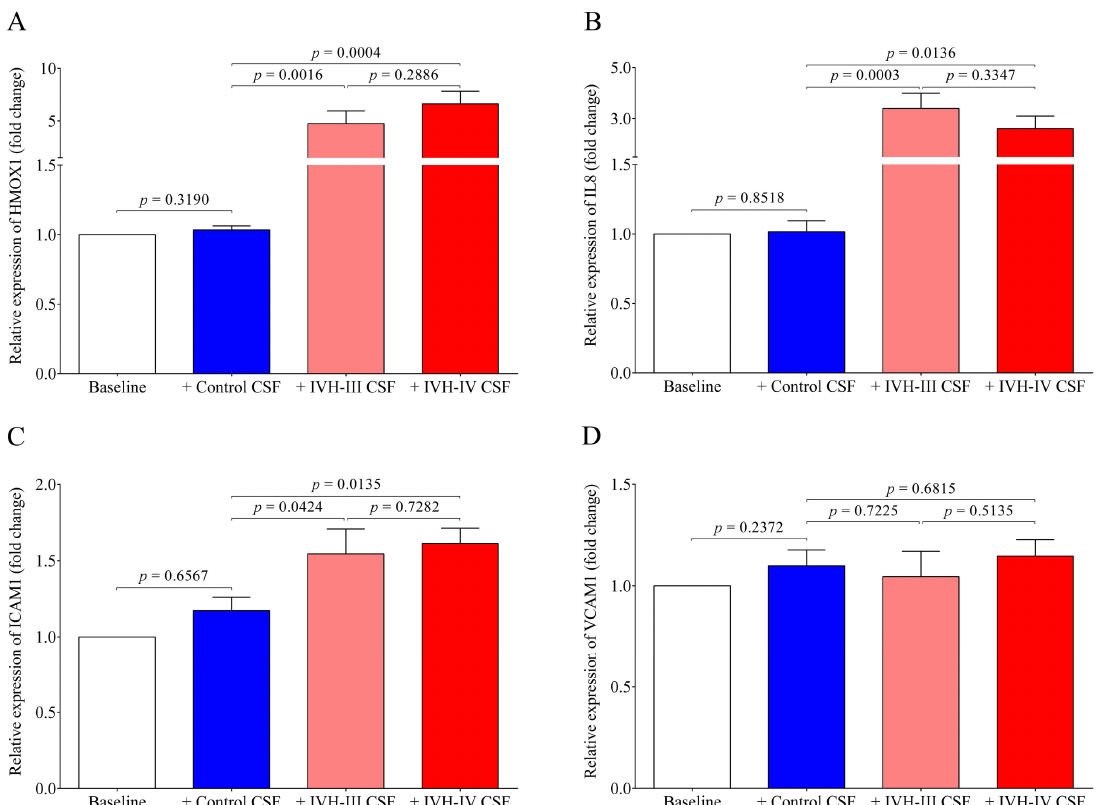
Figure 6. Induction of HMOX1 ( A ), IL8 ( B ), and ICAM1 ( C ) mRNA expression in HCPEpiCs treated with the non-IVH control CSF (blue column) compared to HCPEpiCs exposed to IVH-III (light red) or IVH-IV (red) CSF samples (10 v / v %). HMOX1, IL8, and ICAM1 mRNA expression revealed profound upregulation after exposure to IVH-III and IVH-IV CSF ( A – C ); however, interestingly, no change was observed in the VCAM1 mRNA level ( D ) after 24 h. Mean ± SEM values are depicted, n = 7–8/group. The ANOVA test with Bonferroni’s multiple comparison test was used for the comparisons. Abbreviations: CSF, cerebrospinal fluid; HCPEpiCs, human choroid plexus epithelial cells; HMOX1, heme oxygenase 1; ICAM1, intercellular adhesion molecule 1; IL8, interleukin 8; IVH, intraventricular hemorrhage; mRNA, messenger RNA; and VCAM1: vascular cell adhesion molecule